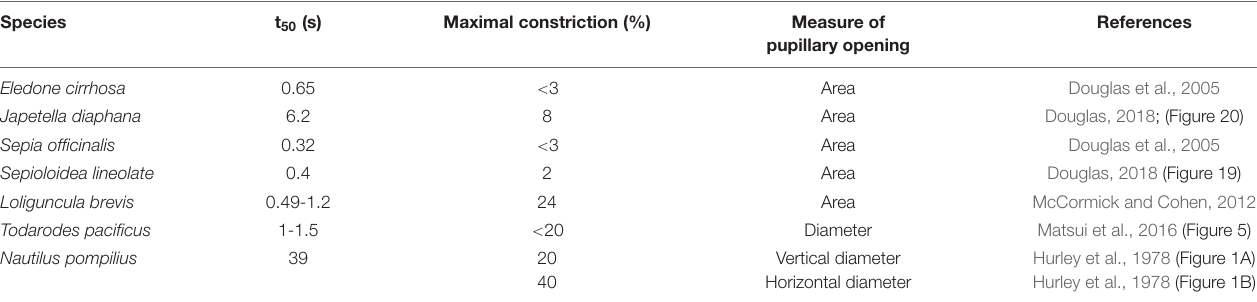
TABLE 1 | Overview of the results obtained in previous studies on pupillary reactions in cephalopods including the t 50 -value, the time interval after light onset, at which half-maximum constriction is reached (in s), the maximal constriction of the pupil (in % of the fully dilated pupil before light onset), the pupillary parameter (either pupil area or pupil diameter) measured during the study, and the